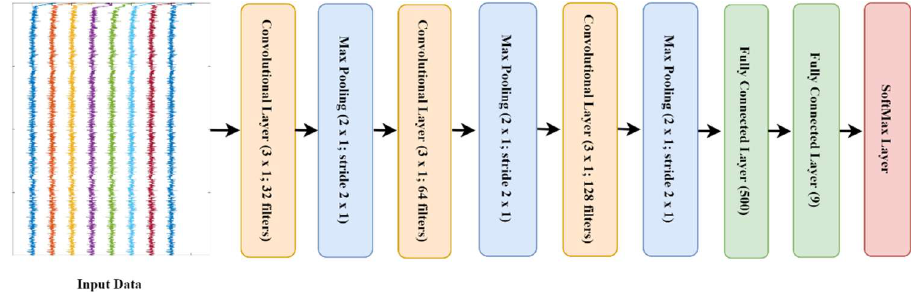
Figure 5. Schematic of convolutional neural network model.